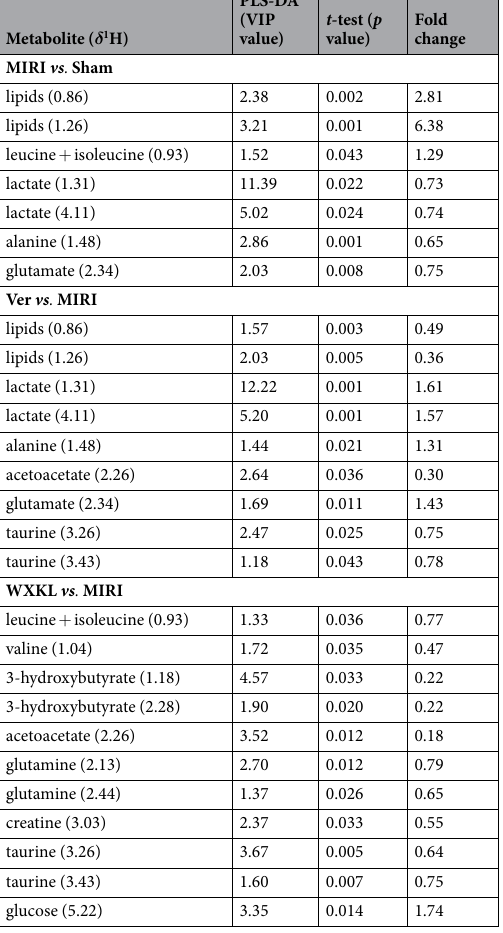
Table 2. The dominating metabolites extracted by multivariate statistical analysis that discriminated the cases of MIRI vs . Sham, Ver vs . MIRI, and WXKL vs .